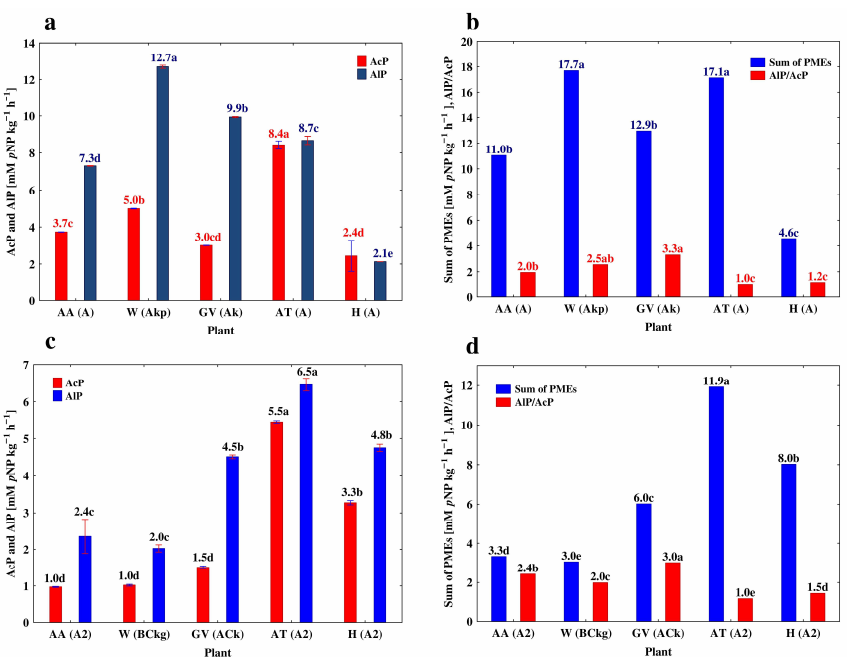
Figure 1. Effect of cultivated plants on the acid and alkaline phosphatase activity (AcP, AlP) and sum of PMEs activities as well as the AcP/AlP ratio in surface horizons (Ap, A, Akp, Ak) (( a , b ), respectively) and in the sub-surface horizons (A2, BCkg, ACk) (( c , d ), respectively). PMEs—the sum of phosphomonoesterases (AcP and AlP). AA—alfalfa, W—winter wheat, GV—grapevine, AT—apple trees, H—hop. Values for each property followed by different letters are statistically different at p < 0.05. Abbreviations of soil horizon names are explained under Table 1.